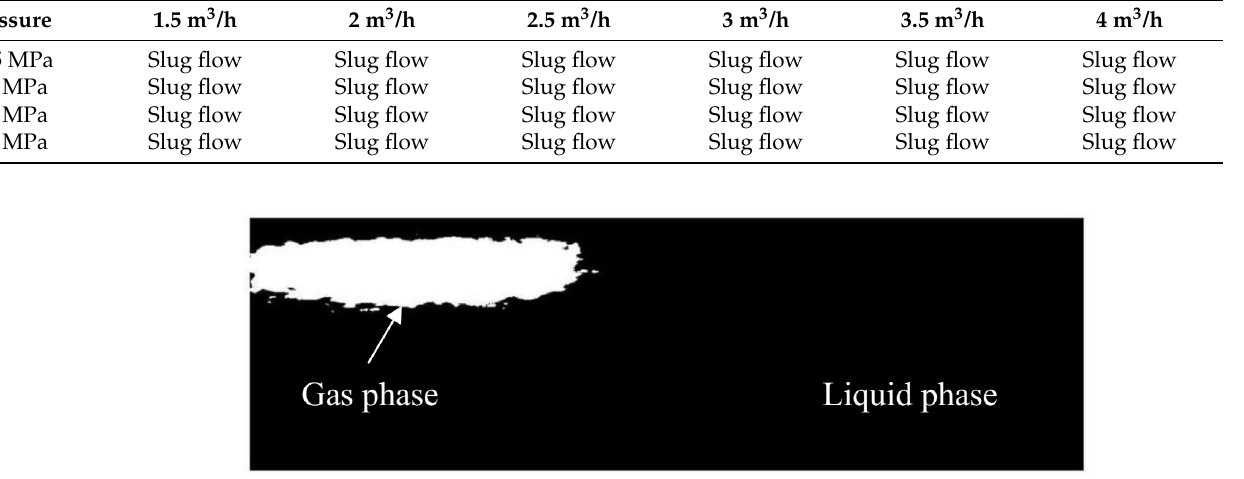
Figure 10. Image after image processing when the pressure is 0.15 MPa and tilted upward by 20°.